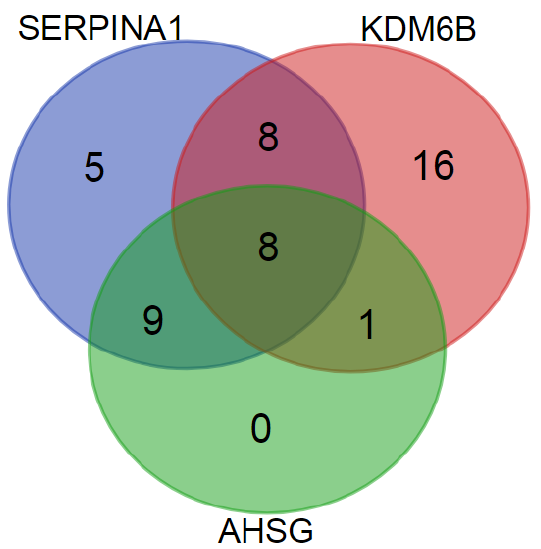
Figure 4. Distribution of SERPINA1, KDM6B, and AHSG peptides among 50 PE urine samples.